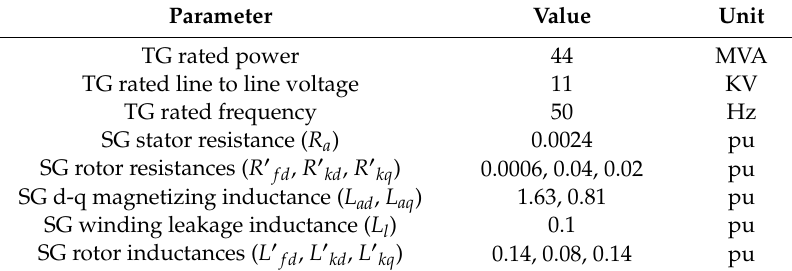
Table 1. TG units’ electrical parameters.